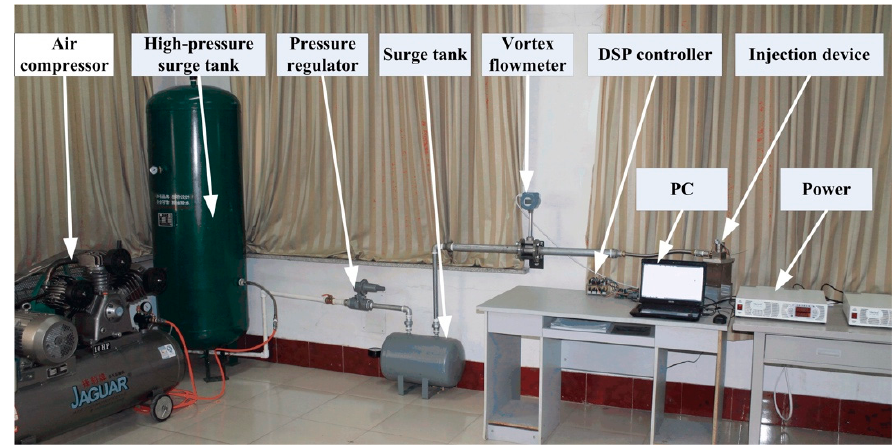
Figure 2. The testing platform of the steady volumetric flow rate.